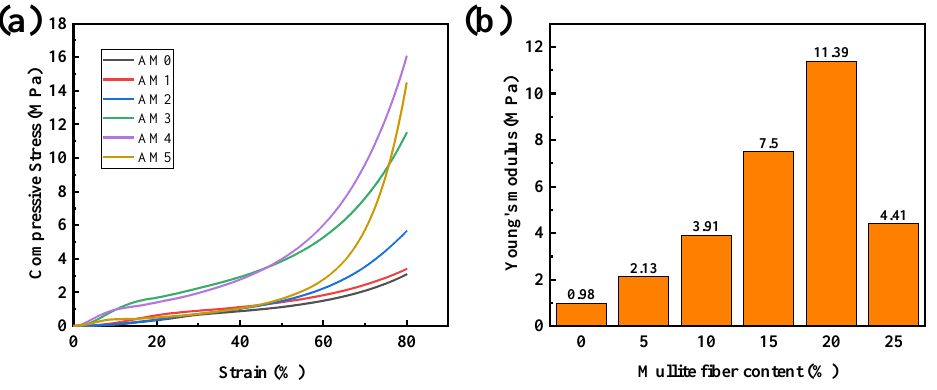
Figure 7. Stress-strain curves ( a ) and Young ’ s moduli ( b ) of the AM samples.